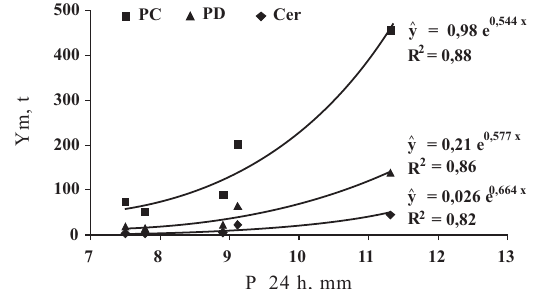
Figura 9. Variação da média do aporte de sedimento anual em função da variação das médias da precipitação em 24